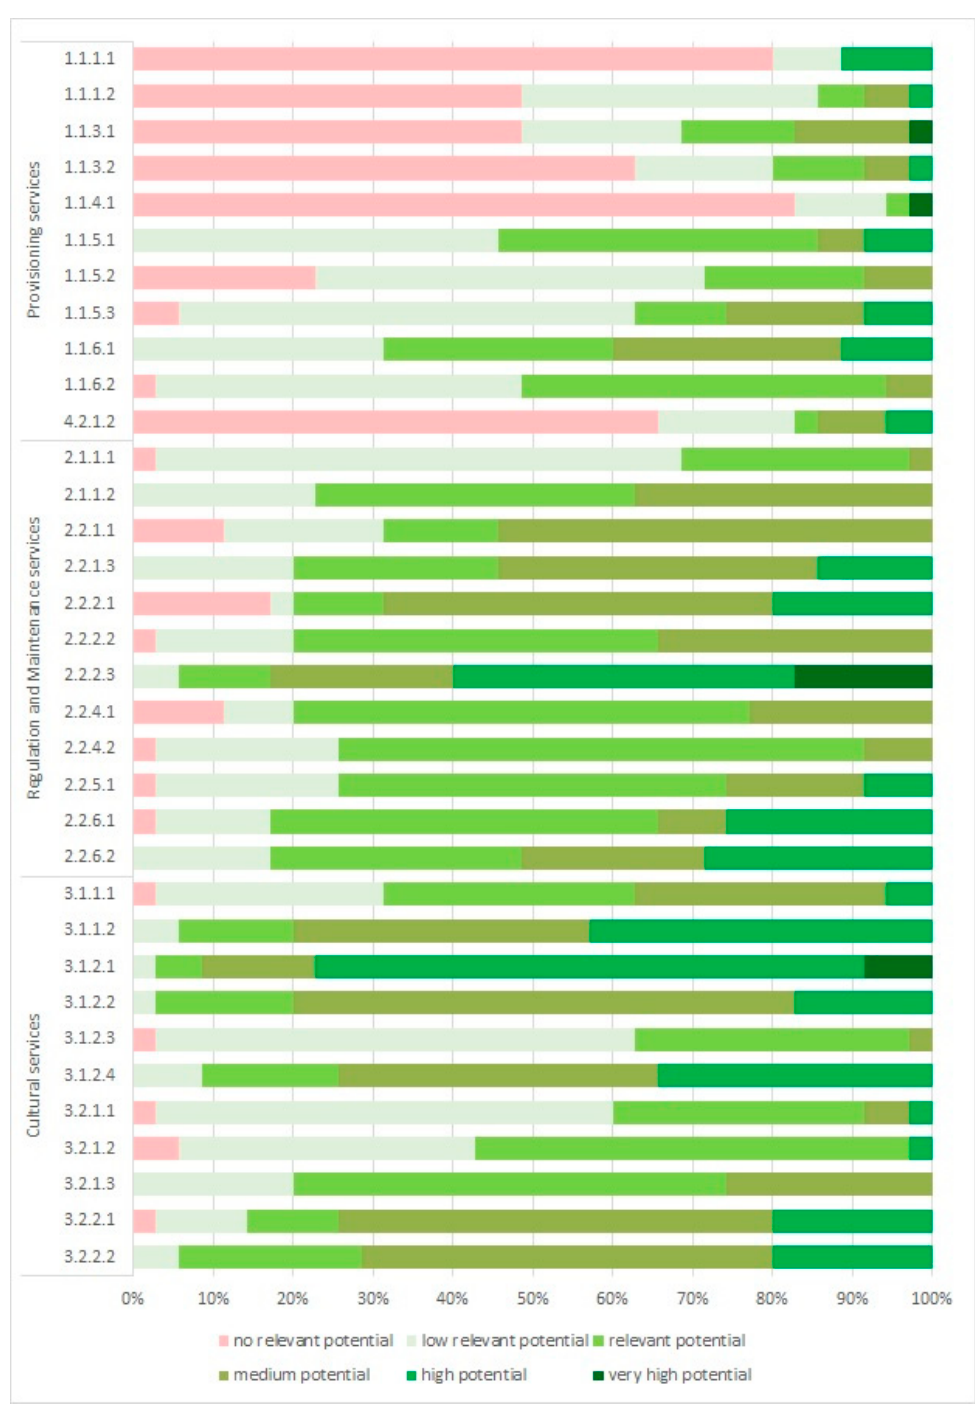
Figure A2. Values of classified Ecosystem Services according to their potentials, based on territorial size in study area.